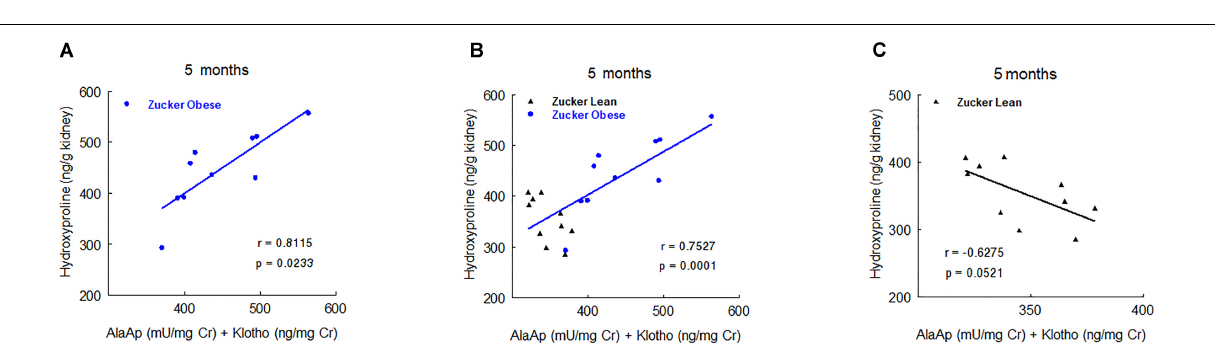
FIGURE 7 | Predictive correlations of the combination of AlaAp and Klotho at 5 months old with renal hydroxyproline content at the end of the experiment in ZO rats ( A , n = 10), in ZL and ZO rats ( B , n = 20) and in ZL rats ( C , n = 10).